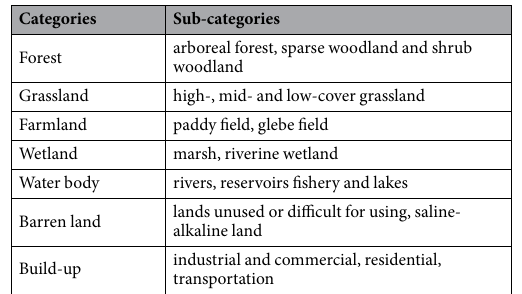
Table 1. The categories of 1:100,000 land use data in riparian zone.